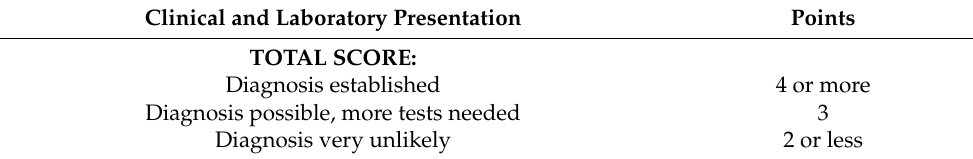
Table 1. Cont. Clinical and Laboratory Presentation Points TOTAL SCORE: Diagnosis established 4 or more Diagnosis possible, more tests needed 3 Diagnosis very unlikely 2 or